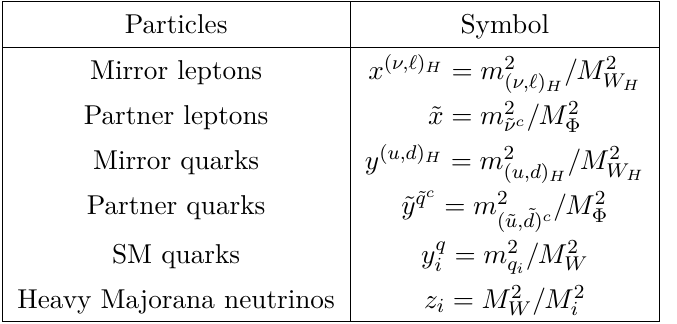
Table 1 . Terminology used in the following calculations, where we have assumed that m ˜ ν c = m ˜ and M are the masses of the heavy Majorana neutrinos, that is the largest scale (which motivated i our definition of the z variable as M 2 /M 2 i i W